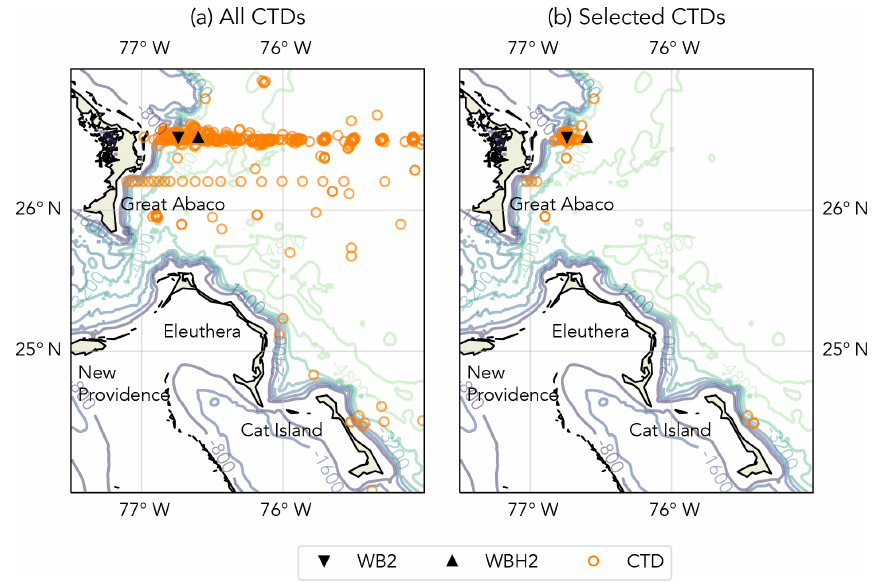
Figure 6. (a) All CTD profiles from the World Ocean Database 2018 in the region shown, compared with (b) those selected as being the most similar distance from the western boundary as the WB2 and WBH2 RAPID